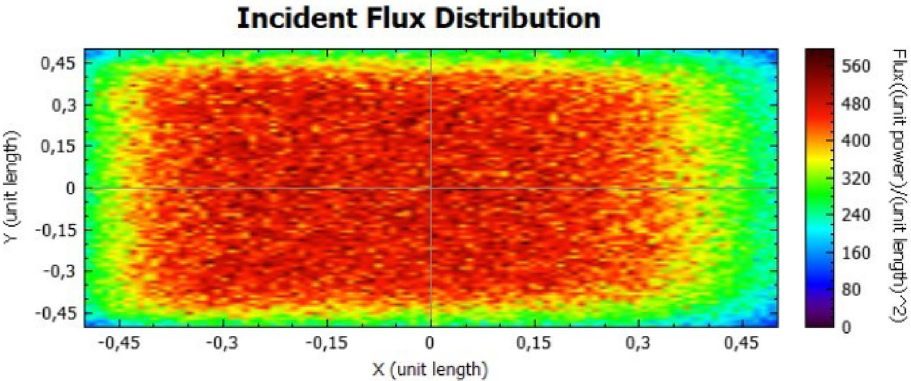
Figure 17. Incident Flux Distribution for an optical error of 0.030 (Flat Concentrator; 47% of reflectivity).